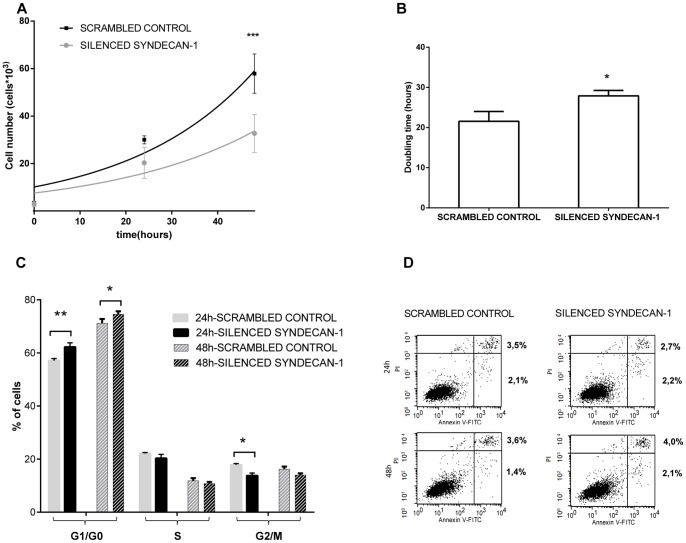
Effect of syndecan-1 silencing on cell growth (A) doubling time (B), cell-cycle distribution (C) and apoptosis (D).(A) Proliferation of cells silenced for syndecan-1 and corresponding scrambled control was measured using WST1 proliferation assay. Values are mean of cell number ± SD (n = 3), obtained from three independent experiments with 4 replicates in each. (B) Doubling time was calculated from the logarithmic phase of the growth curve. Silencing of syndecan-1 significantly decreased proliferation of mesothelioma cells (*p<0.05, ***p<0.001). (C) Cell cycle analysis was performed by propidium iodide staining followed by flow cytometry, 24 and 48 hours after silencing. Columns represents mean percentage of cells in each phase of the cell cycle ± SD (n = 3) (D) Apoptosis was measured by flow cytometry using Annexin-V-FITC and Propidium iodide (PI) staining. Cells silenced for syndecan-1 and scrambled controls were stained with PI and Annexin-V, 24 and 48 hours after syndecan-1 silencing. Three independent experiments were performed. Representative Annexin V/PI plots are shown where X axis shows the log of fluorescence intensity of Annexin-V and Y axis demonstrate the log of fluorescence intensity of PI. Cells in the lower left quadrant represent living cells, in the lower right quadrant early apoptotic cells; the upper right and left quadrant show late apoptotic and necrotic cells, respectively. No significant change in apoptosis was recorded. Asterisks indicate statistically significant differences compared to the scrambled control (* p≤0.05, ** p≤0.01, *** p≤0.001). A two-tailed t test was performed to test the statistical significance between cells silenced for syndecan-1 and scrambled control. SD = standard deviation.